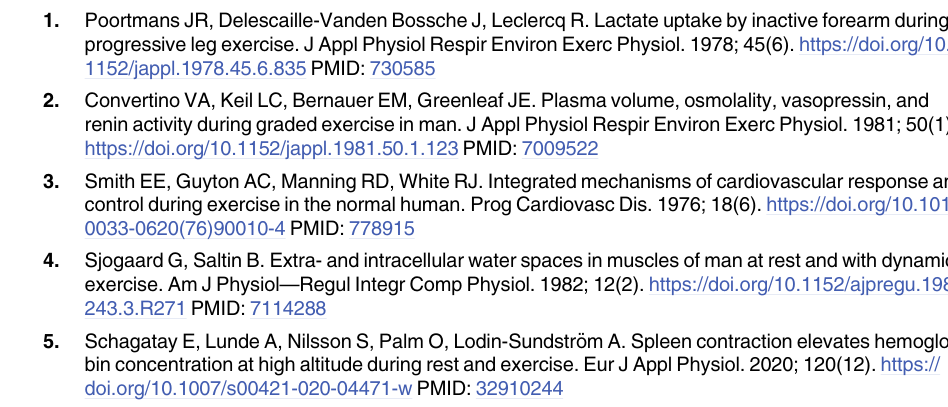
S1 Table. Database of the short (HS) and long (DHS) protocol. Rest: baseline values, sam- pling time before exercise. RER 0.9: median value 0.9 of the Respiratory Exchange Ratio (the aerobic range of the exercise). RER 1.0: median value 1.0 of the Respiratory Exchange Ratio (the anaerobic threshold of the exercise). Max: sampling time at the maximum exercise of the short protocol. VM: sampling time at the maximum of the long protocol exercise. 20’, 40’, . . . , 120’: sampling times at 20 th , 40 th , . . . , 120 th minutes of the long protocol exercise, respectively. R5’ and R30’: sampling times at the 5 th and 30 th minutes of the recovery period, respectively. SMM: skeletal muscle mass; ICW: intracellular water; ECW: extracellular